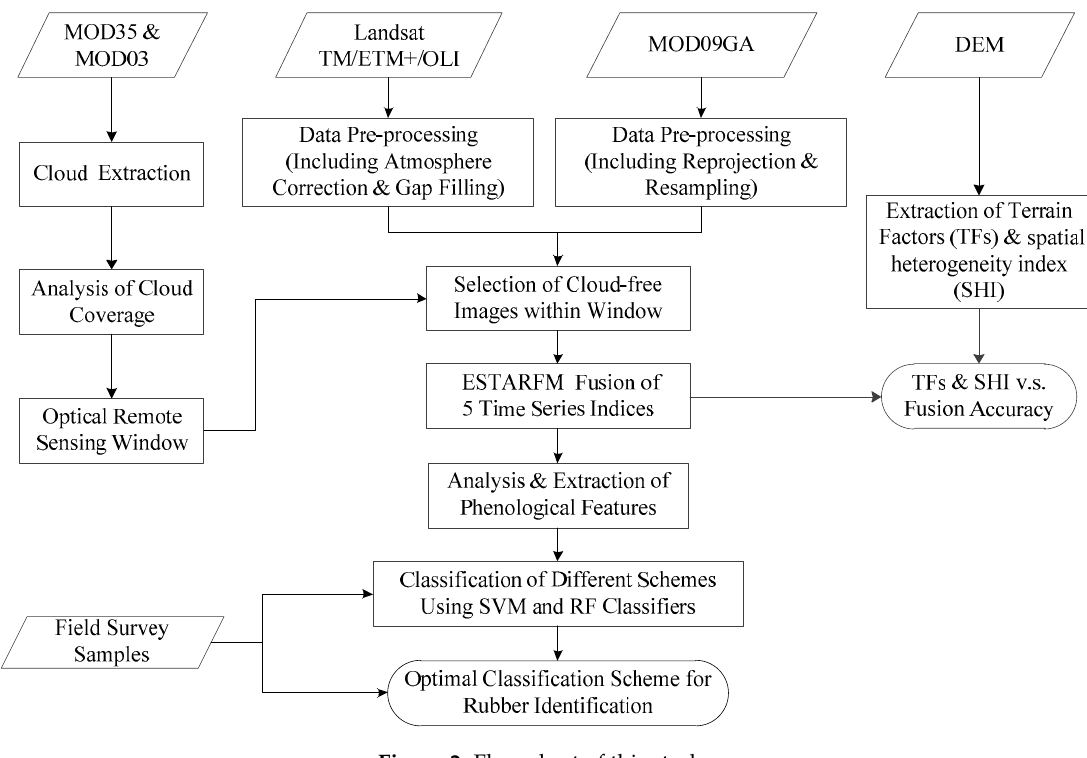
Figure 2. Flow chart of this study.